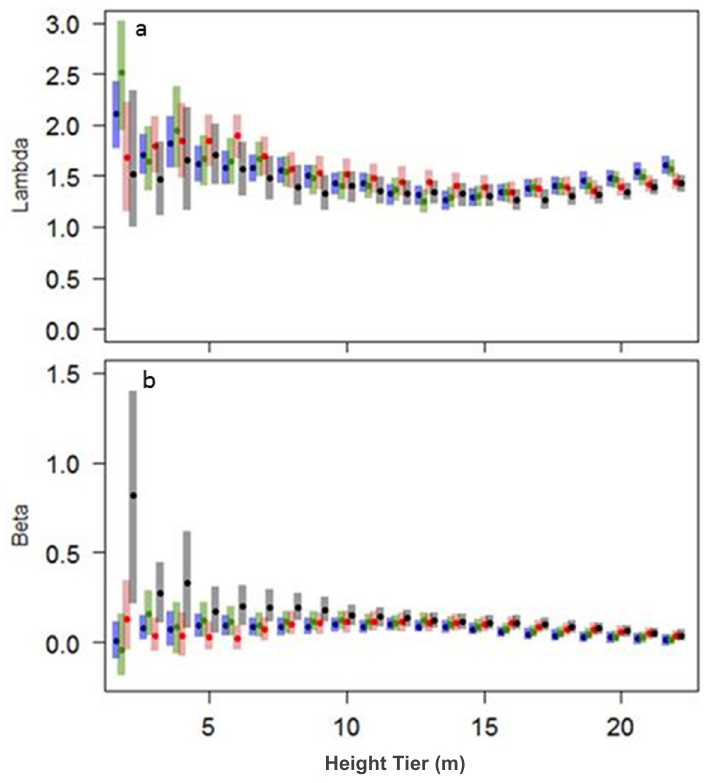
Figure 6. Values of λ ( top panel ) and β ( bottom panel ) estimated by fitting a modified power law function to the frequency distribution of canopy gap sizes observed at various heights above the forest floor, in four forest blocks in Gola National Park, Sierra